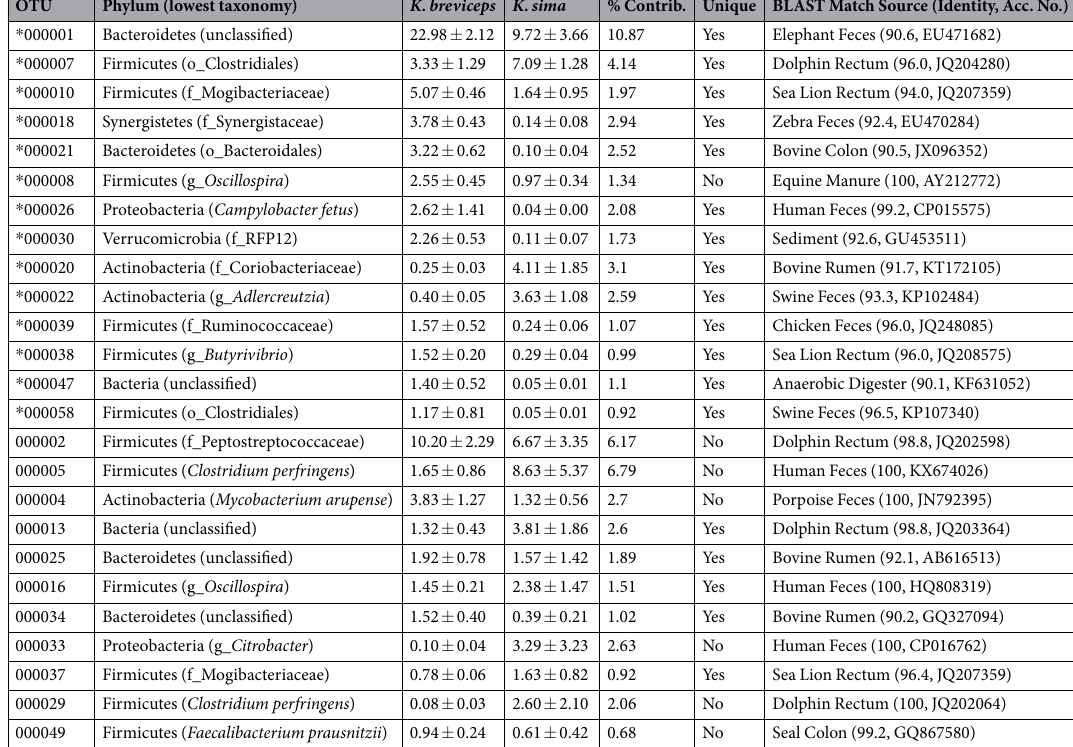
Table 2. Common OTUs in the gut microbiomes of Kogia breviceps and K . sima , showing phylum- and lowest- level taxonomy, relative abundances, and percentage contributions to dissimilarity between hosts (SIMPER analysis). Unique OTUs were those not detected in other whale species (comparative analysis herein). BLAST matches show the source and identity (%) of the closest known relative for each OTU. Asterisks ( * ) denote differentially abundant OTUs between kogiid